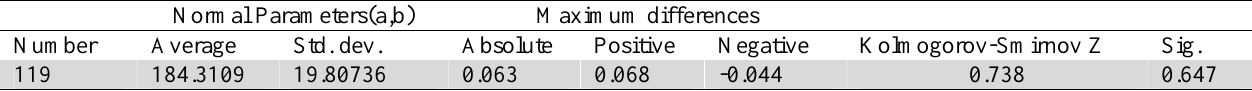
Results of Single Sample Kolmogorov-Smirnov Test Normal Parameters(a,b)